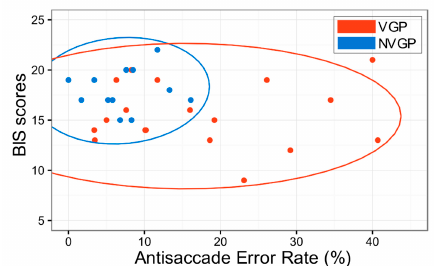
Figure 4. The scatter plot with 95% confidence ellipse for antisaccade error rate and BIS scores. VGP and NVGP were represented in red and blue. BIS: Behavioral Inhibition System. There was some limitation of our study is the difference in gender ratio between groups. In fact, the lack of gender balance, i.e., a male dominancy, is one of the typical aspects characterizing the video game population [94]. This does not only make it practically difficult to recruit video game